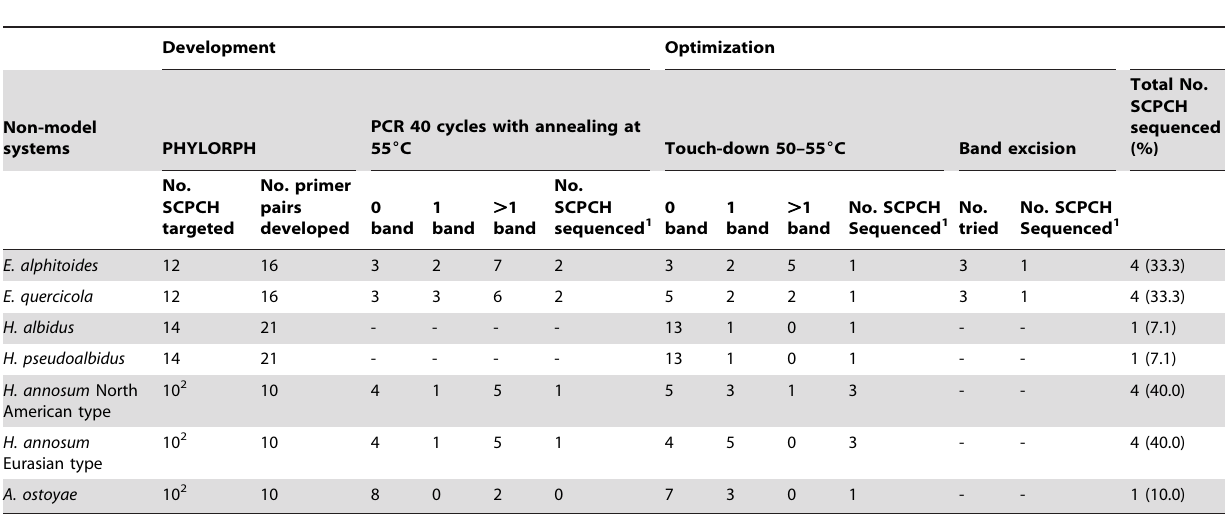
Table 1. PCR and sequencing results for the SCPCH candidates tested across the four non-model systems used as test